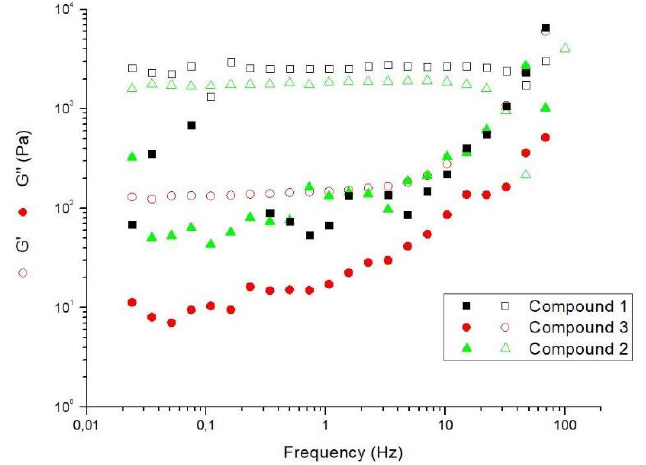
Figure 6. Frequency dependence of the shear elastic G’ and G” module for the dehydrodipeptides Figure 6. Fr equency dependence of the shear elastic G’ and G″ module for the dehydrodipeptides 1 – 3 at 0.20 wt%. 1 – 3 at 0.20 wt%.